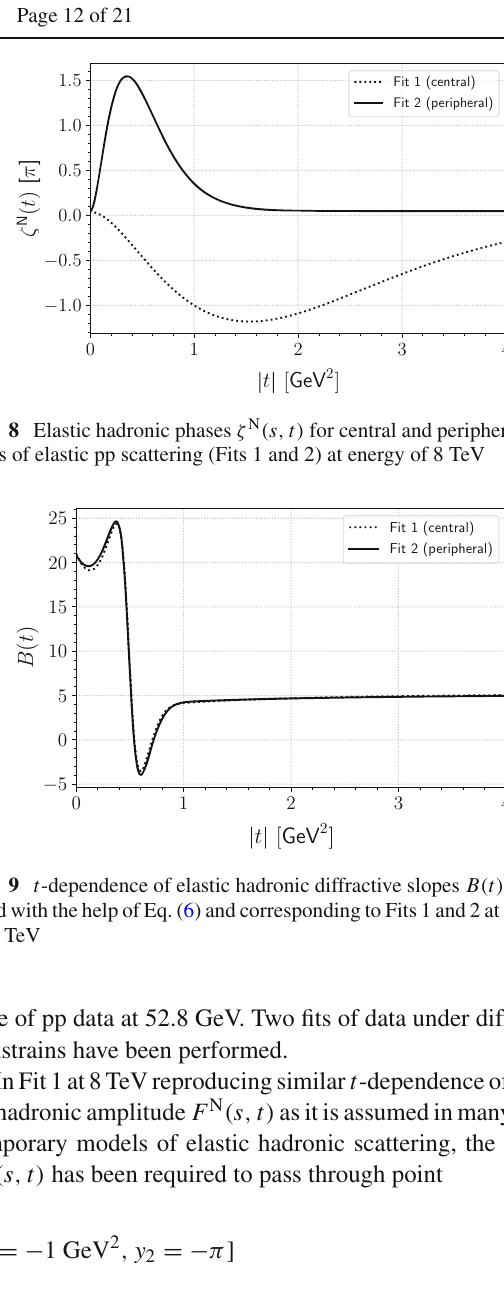
case of pp data at 52.8 GeV. Two fits of data under different constrains have been